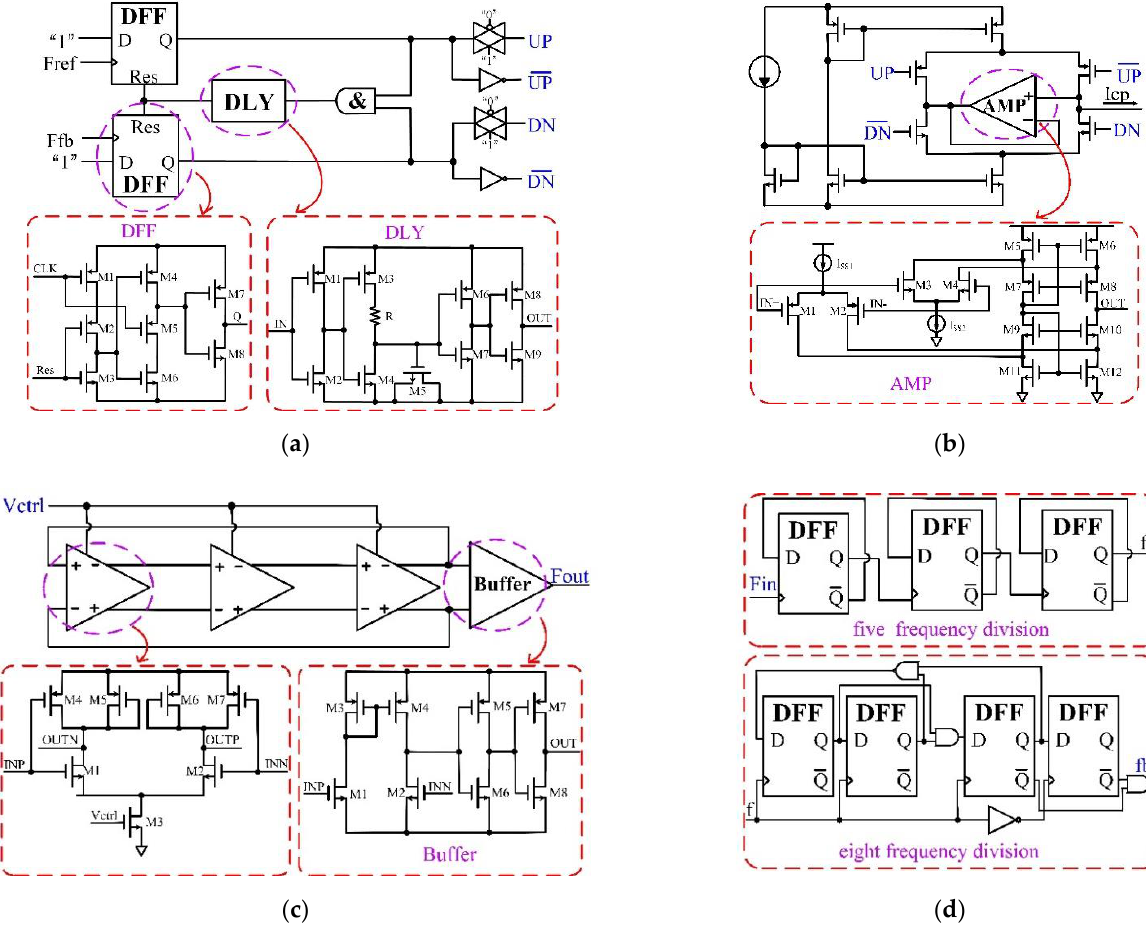
Figure 3. This work uses the submodule circuit of a CPPLL: ( a ) topology of three-state frequency and phase detector based on D-flip-flop; ( b ) topology of charge pump with unity gain amplifier; ( c ) topology of voltage-controlled oscillator cascaded with three differential-delay units; ( d ) topology of frequency divider cascaded with D-flip-flop.